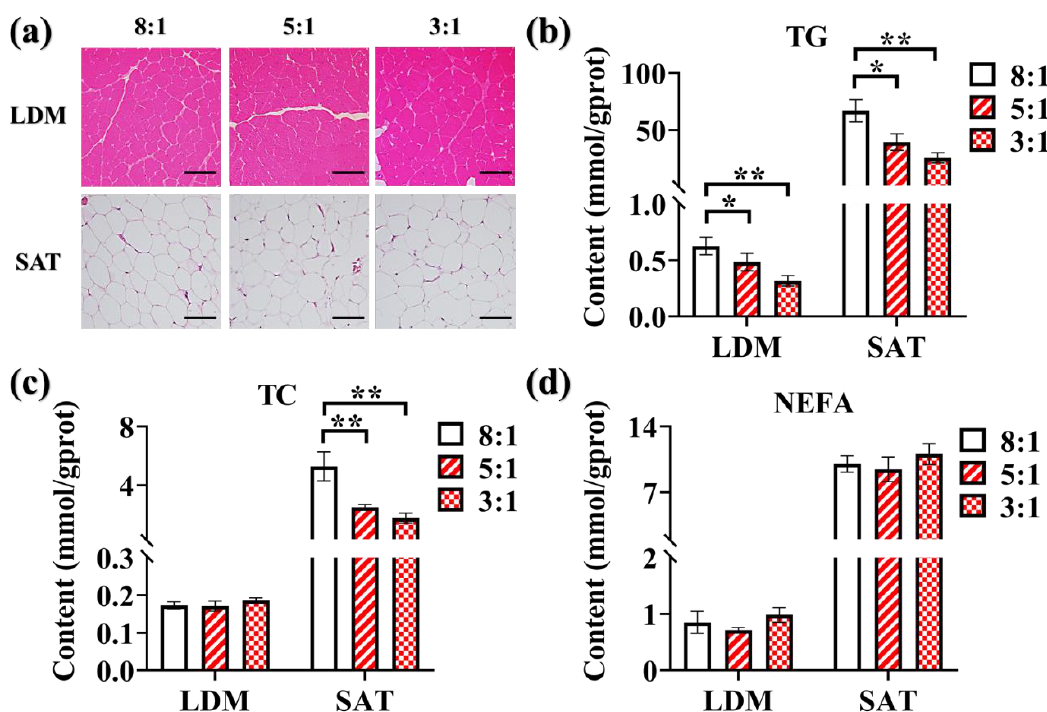
Figure 1. Morphological structure and the contents of triglyceride (TG), total cholesterol (TC), and non-esterified fatty acid (NEFA) in Longissimus dorsi muscle (LDM) and subcutaneous adipose tissue (SAT) from Heigai pigs fed with different diets. ( a ) Histological images (×100) of Hematoxylin-Eosin staining showed the influences of different n-6/n-3 PUFA ratio diet on LDM and SAT morphological structure of Heigai pigs; scale bar = 200μm. The influences of different n-6/n-3 PUFA ratio on TG ( b ), TC ( c ), and NEFA ( d ) contents in LDM and SAT of Heigai pigs. ‘8:1, 5:1, 3:1’: different n-6/n-3 PUFA ratio diets. Results were presented by mean ± standard error of the mean (SEM) (n = 6). ‘*’ p < 0.05; ‘**’ p < 0.01.